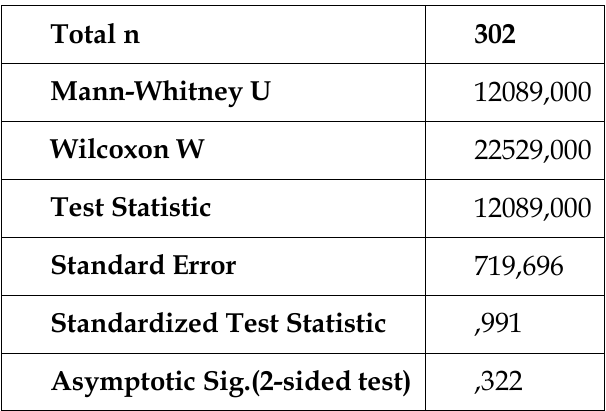
Table 24. Trust towards the health centre and gender. Mann-Whitney U sig.